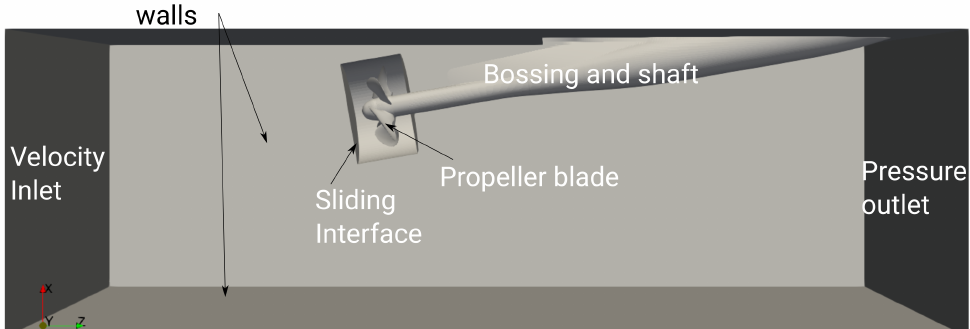
Figure 4. Simulation configuration for propeller A tested in the cavitation